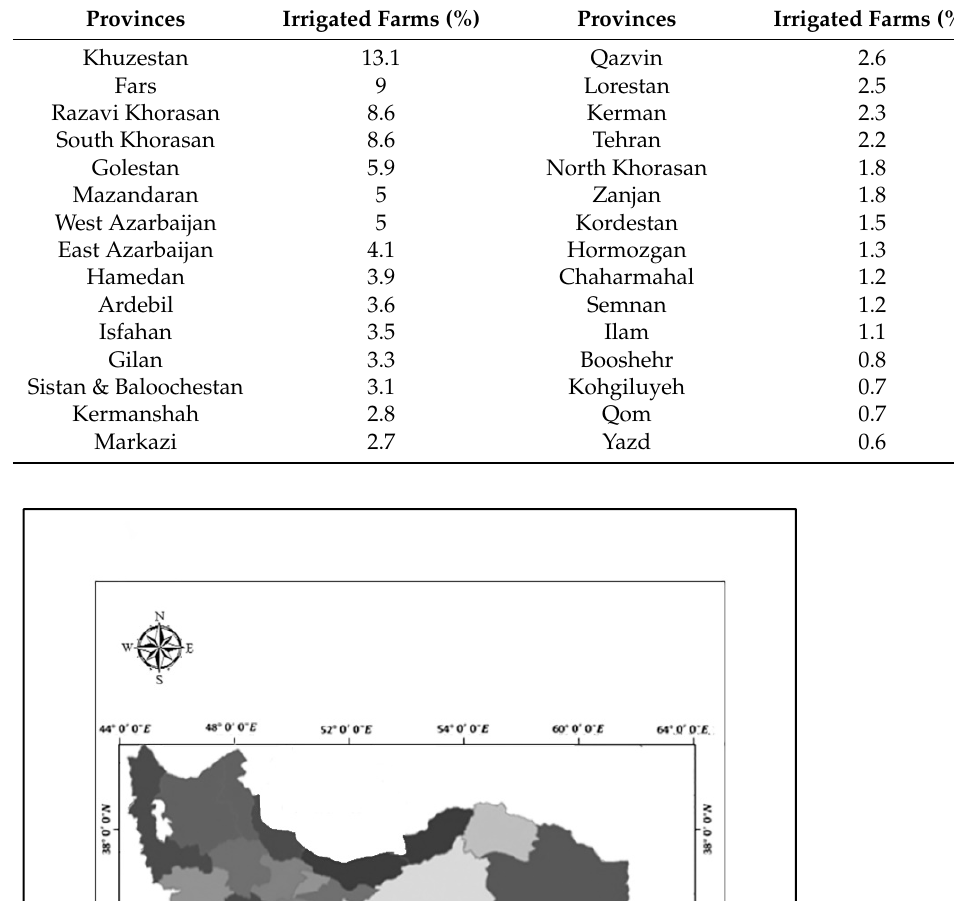
Table 7. Percentage of irrigated farms in Iranian provinces ( Ministry of Agriculture –2016).